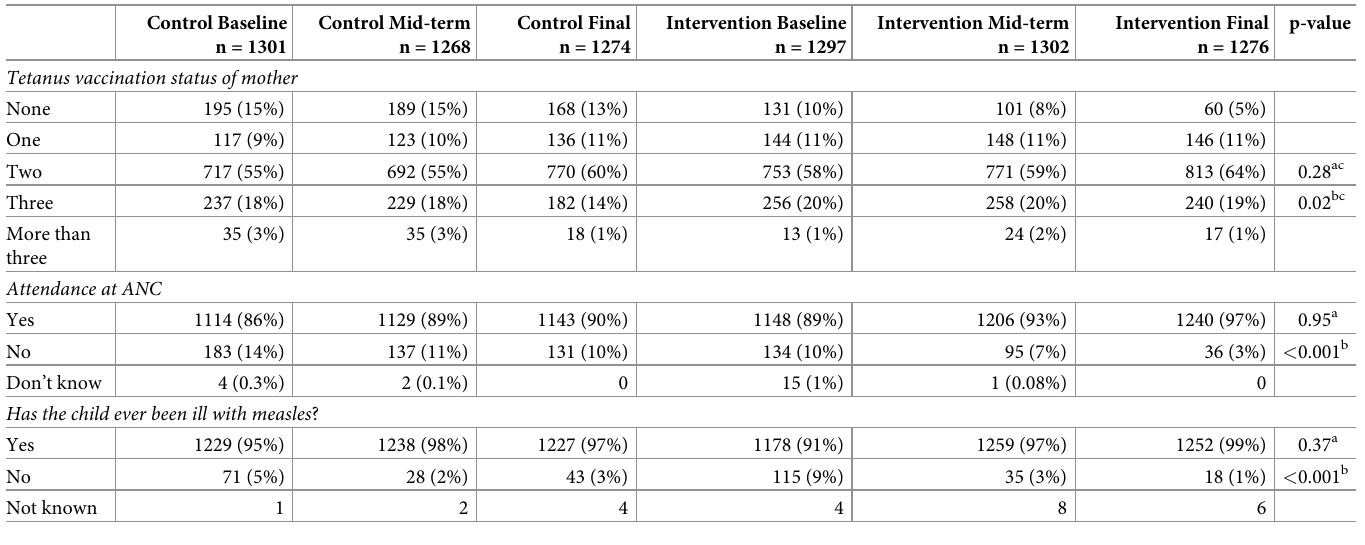
Table 6. Health-care utilisation by the mother, and child